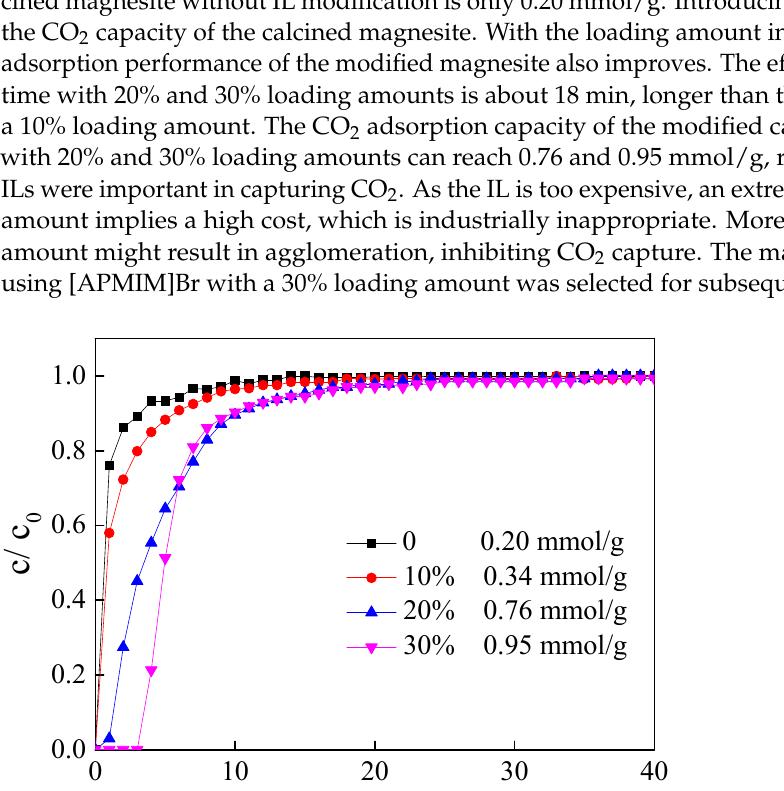
Figure 6. Adsorption curves and CO 2 capacity of magnesite modified by [APMIM]Br at different temperatures (3 g, 30% loading amount, 100 mL/min flow rate and 0 MPa).